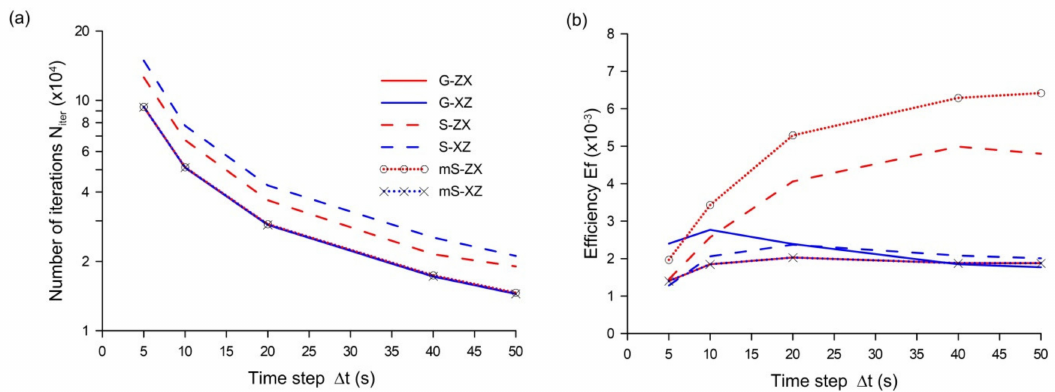
Figure 9. Dependence of the number of iterations N iter (logarithmic scale) ( a ) and e ffi ciency Ef according to Equation (48) ( b ) on the time step ∆ t for various splitting algorithms.